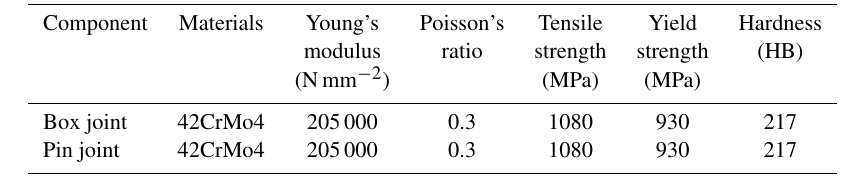
Table 1. Material properties.